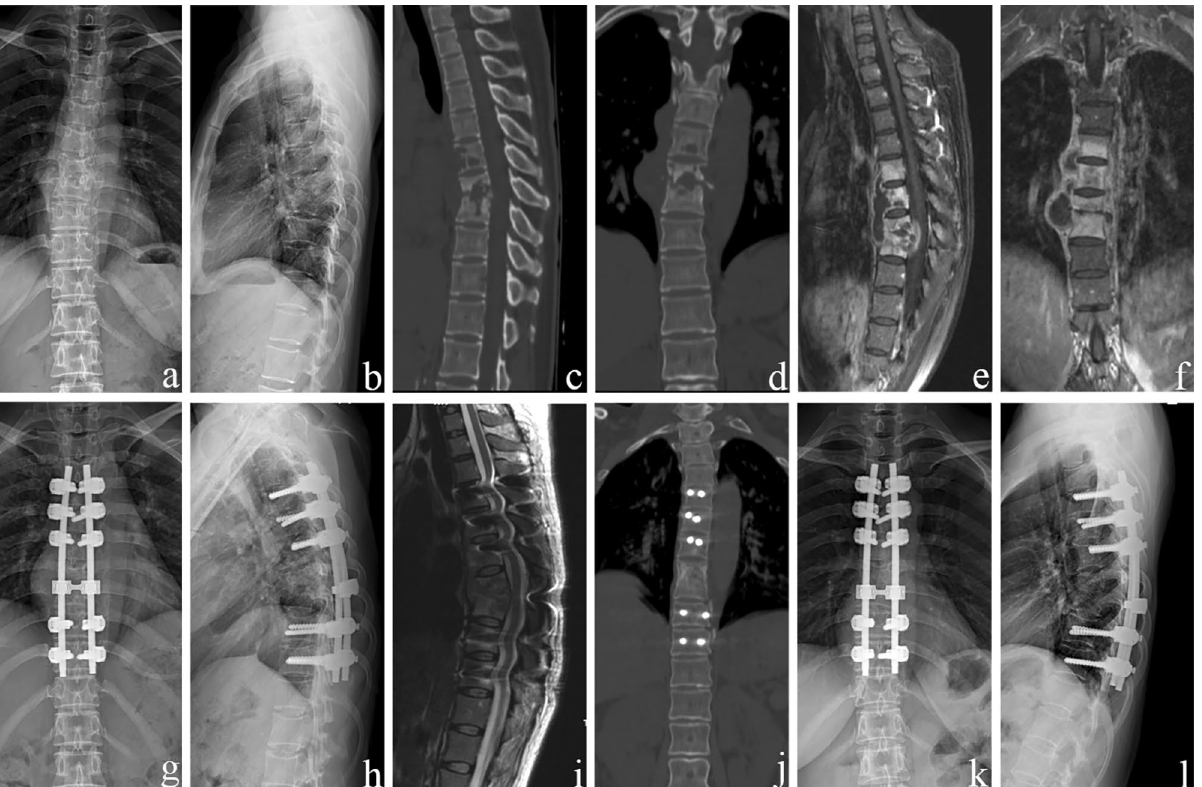
Figure 3. A 49-year-old female demonstrating lesions received a one-stage posterior transforaminal thoracic debridement, interbody fusion, and instrumentation. ( a – f ) Preoperative radiographs, CT, and MRI scans show TB of T5–T8 with vertebral bone destruction and deformity (kyphosis angle 36°) and paravertebral abscess formation. ( g , h ) Postoperative radiographs demonstrate the correction of the deformity (kyphosis angle 23°). ( i ) Postoperative MRI that shows clearance of TB lesions and spinal cord decompression. ( j ) CT shows satisfactory bone fusion at 12 months. ( k , l ) Radiographs display good internal fixation position and solid bone fusion, with a correction loss of 1° after 81 months of